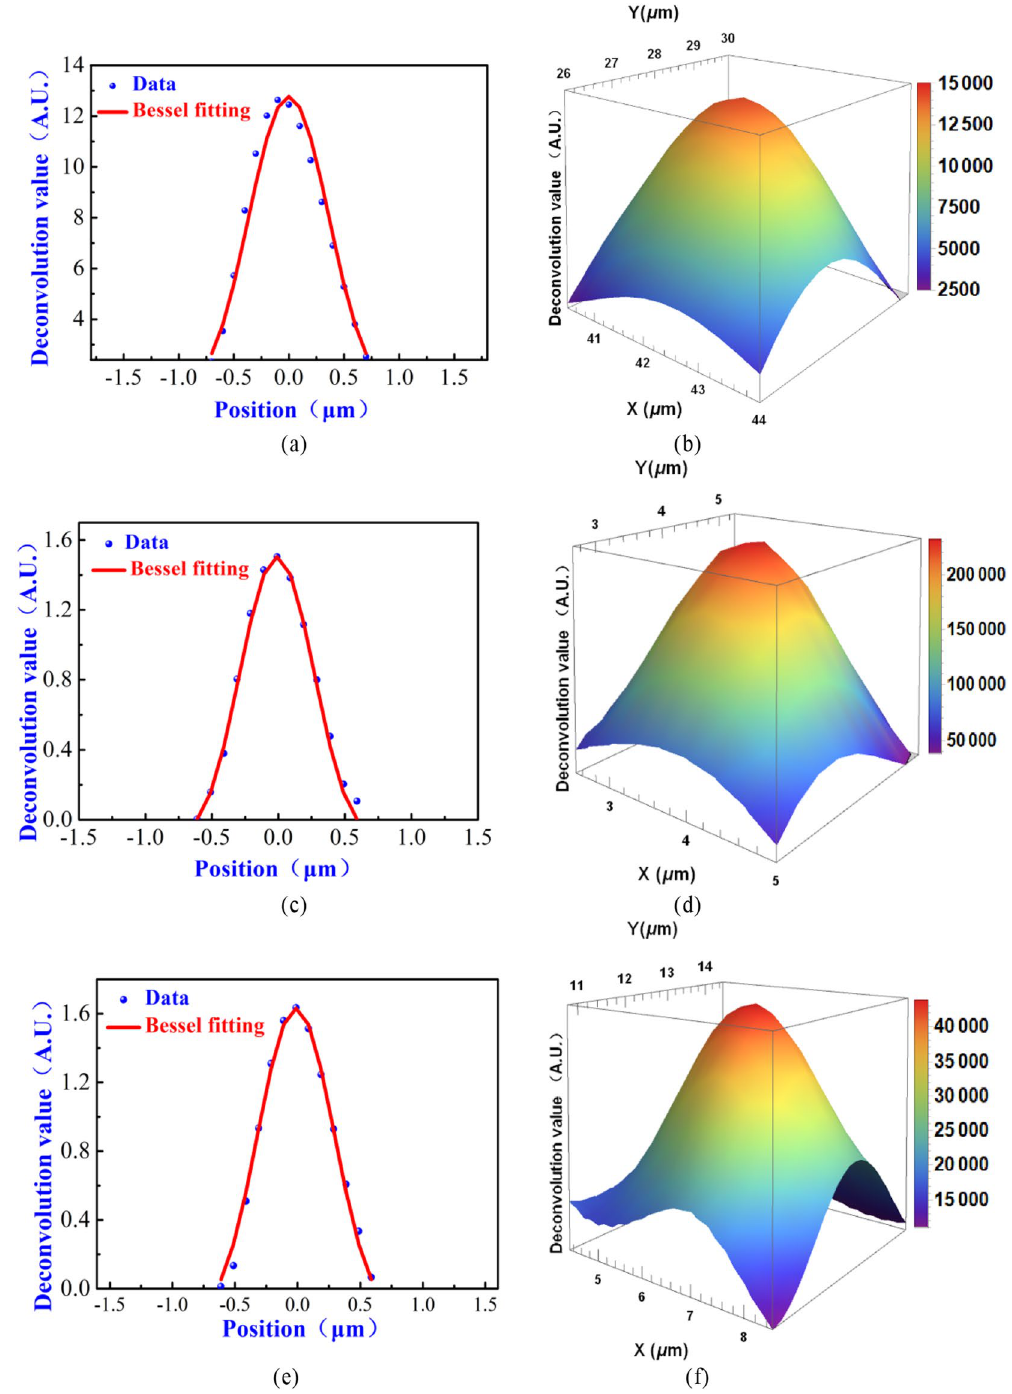
Figure 4. Deconvolution results of the relative photoresponse ( PCR ) of the SiPMs: ( a ) 1D and ( b ) 2D (shown in 3D-view) deconvolution results obtained by the FBK SiPM with 35 μm Gm-APD cell pitch (model = NUV- HD-LF); ( c ) 1D and ( d ) 2D (shown in 3D-view) deconvolution results obtained by the NDL SiPM with 10 μm cell pitch (model = EQR1011-1010C-T); ( e ) 1D and ( f ) 2D (shown in 3D-view) deconvolution results obtained by the Hamamatsu SiPM with 10 μm cell pitch (model =